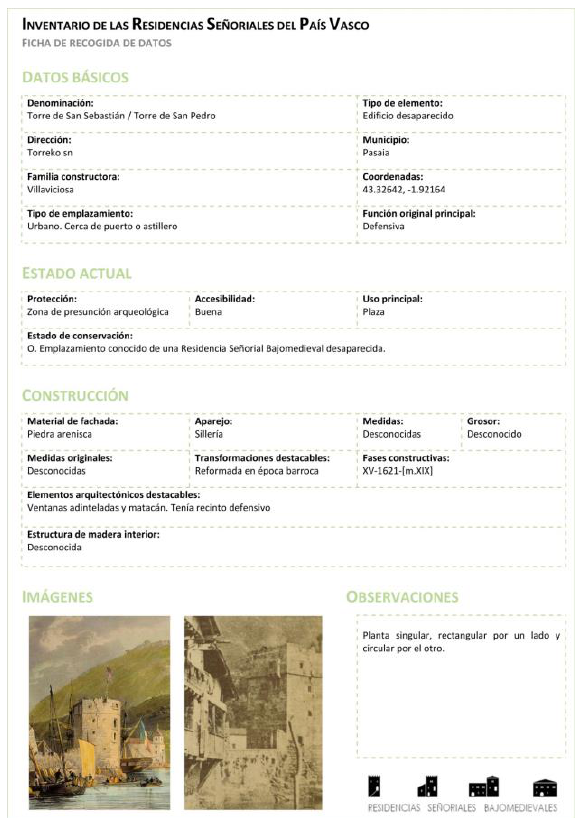
Figure 1. Data collection sheet: Tower of San Pedro